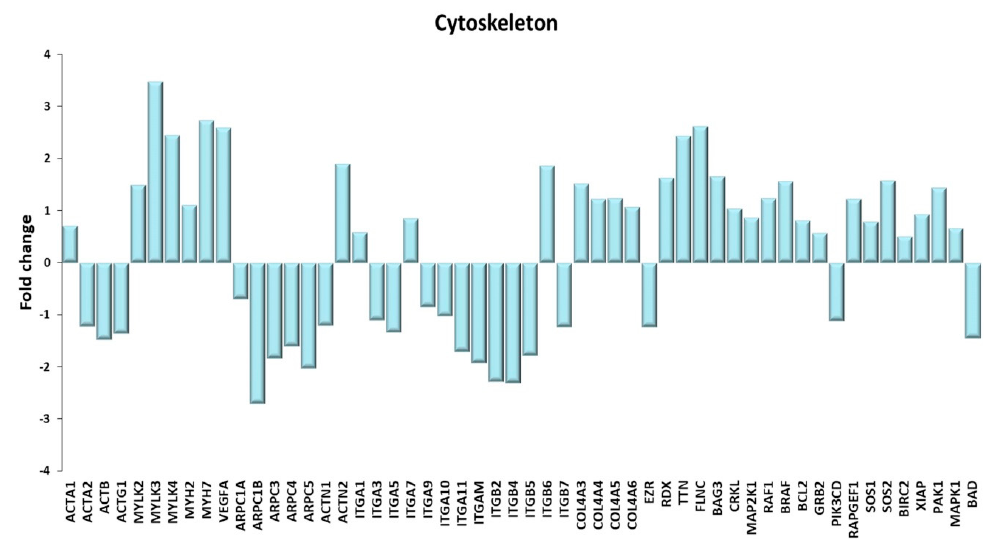
Figure 11. Cytoskeleton. A Genes discussed in the text are shown here as fold change in the comparison of TRA and SED subjects. ACTA1: actin α 1, skeletal muscle; ACTA2: actin α 2, smooth